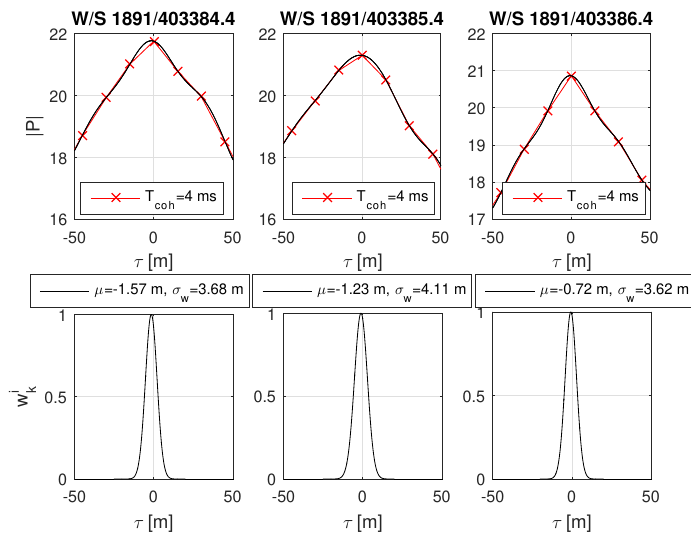
Figure 13. Real-world open sky scenario of satellite GPS L1 C/A Pseudo-Random-Noise (PRN) number 12. The plots show from left to right three epochs referring to GPS Week/Second W/S. The weighted standard deviations σ w approach the theoretical lower limit of σ ∆ τ = 3 m for this ideal case. The dataset was recorded on the roof at LAT = 47.06446263 deg, LON = 15.40777110 deg at the Reininghausstraße 13a, Graz, Austria. The red crosses in the upper plots show the correlation values at code offset τ . The black line in the upper plot shows the sinc interpolated correlation values, which are used to obtain the weights w i shown in the lower plots. k